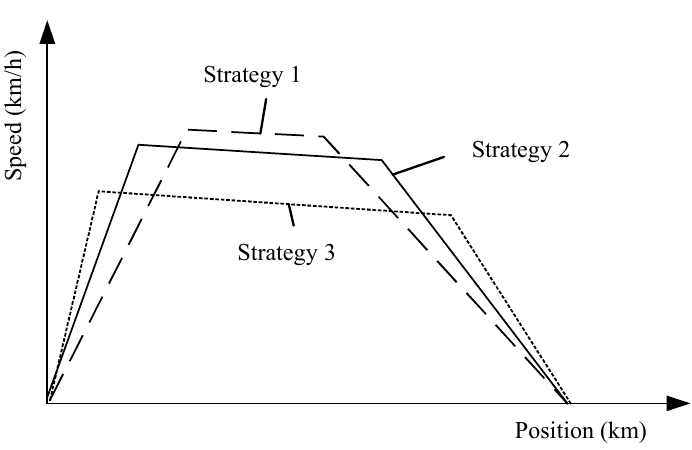
Figure 1. Different driving strategies of trains between successive